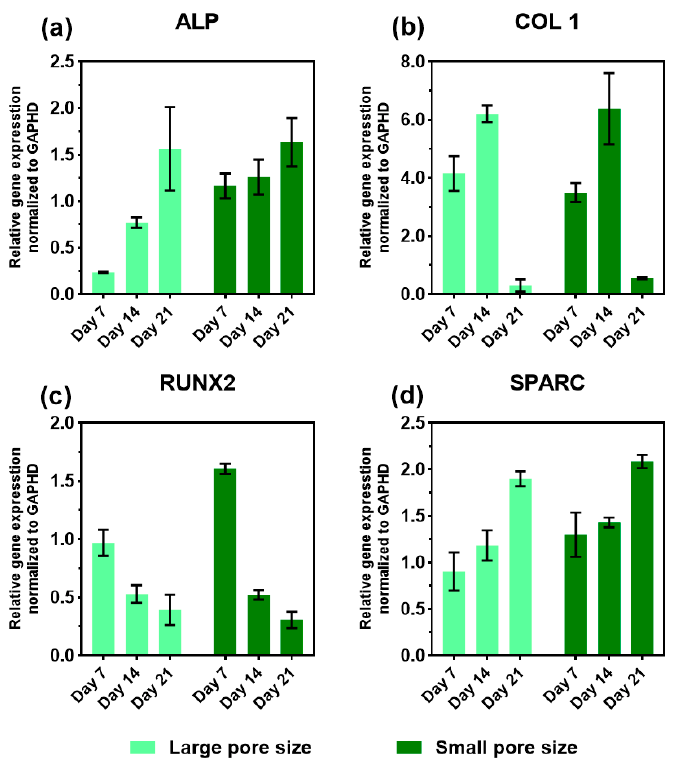
Figure 7. Relative gene expression of ALP ( a ), COL 1 ( b ), RUNX2 ( c ), and SPARC ( d ) of hMSCs on SiOC(N) ceramic scaffolds with different pore sizes after culturing in osteogenic medium for day 7, 14, and 21. TCP with hMSCs was used as a reference group. GAPDH was used as a housekeeping gene. n = 8.